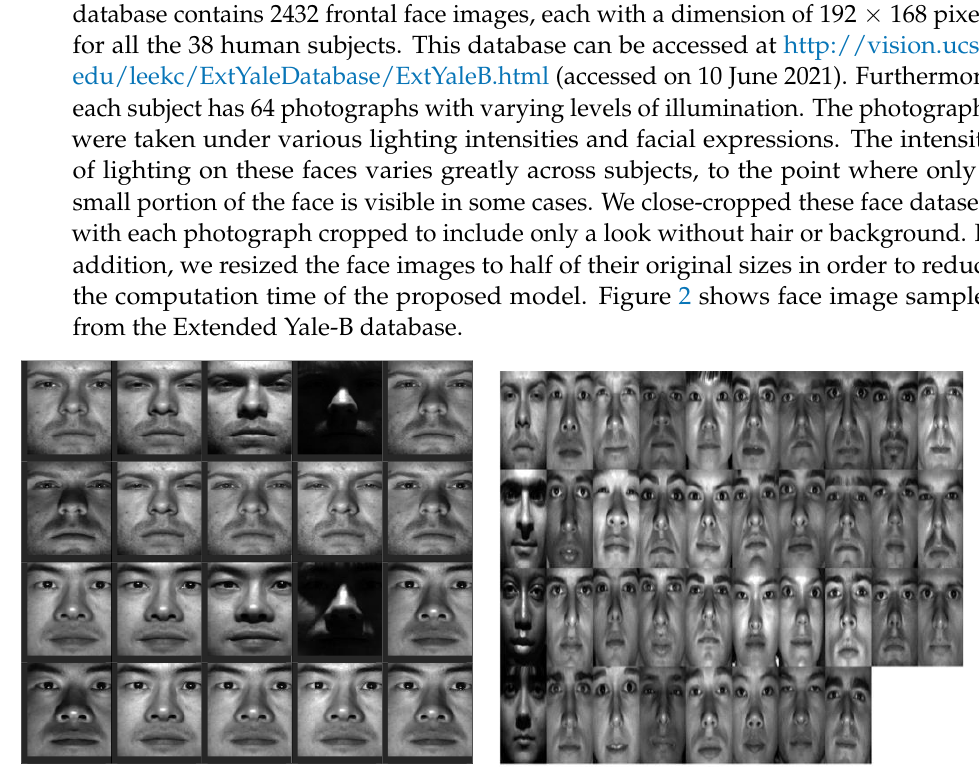
Table 1. Characteristics of databases